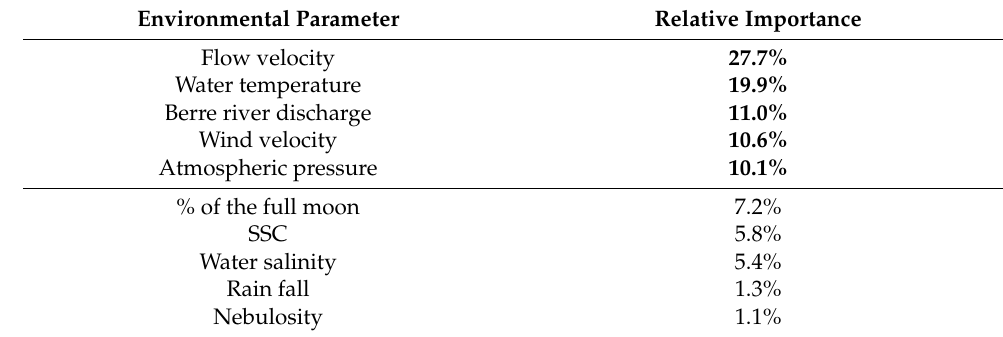
Table 2. Relative importance of the 10 environmental parameters explored in order to explain the number of eels swimming toward the lagoon over the 18:00–midnight period from the Boosted Regression Tree (BRT). The bold values highlight the parameters with a relative importance >10% for which the dependence plots were displayed.